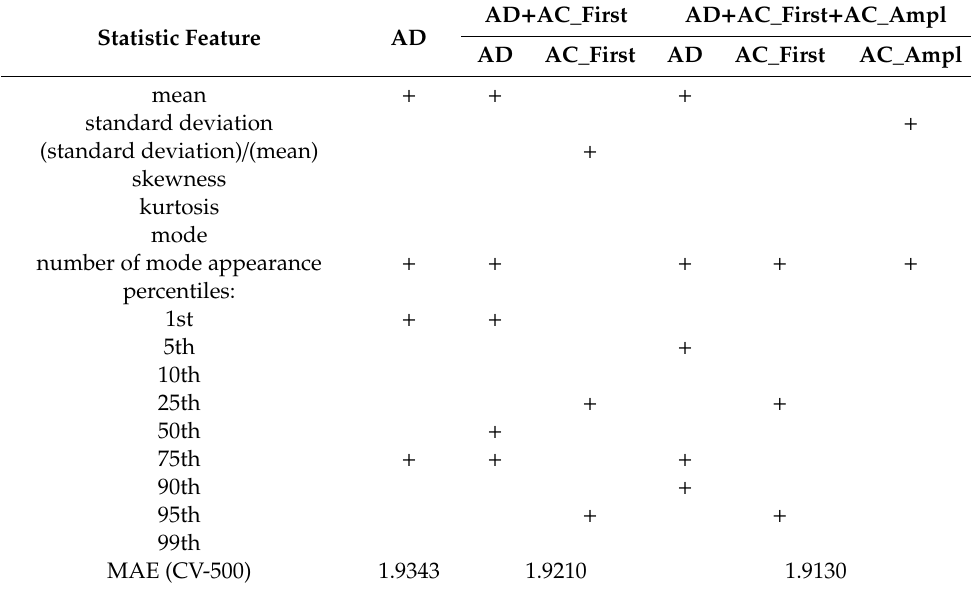
Table 1. Optimal subsets of features and corresponding mean absolute errors